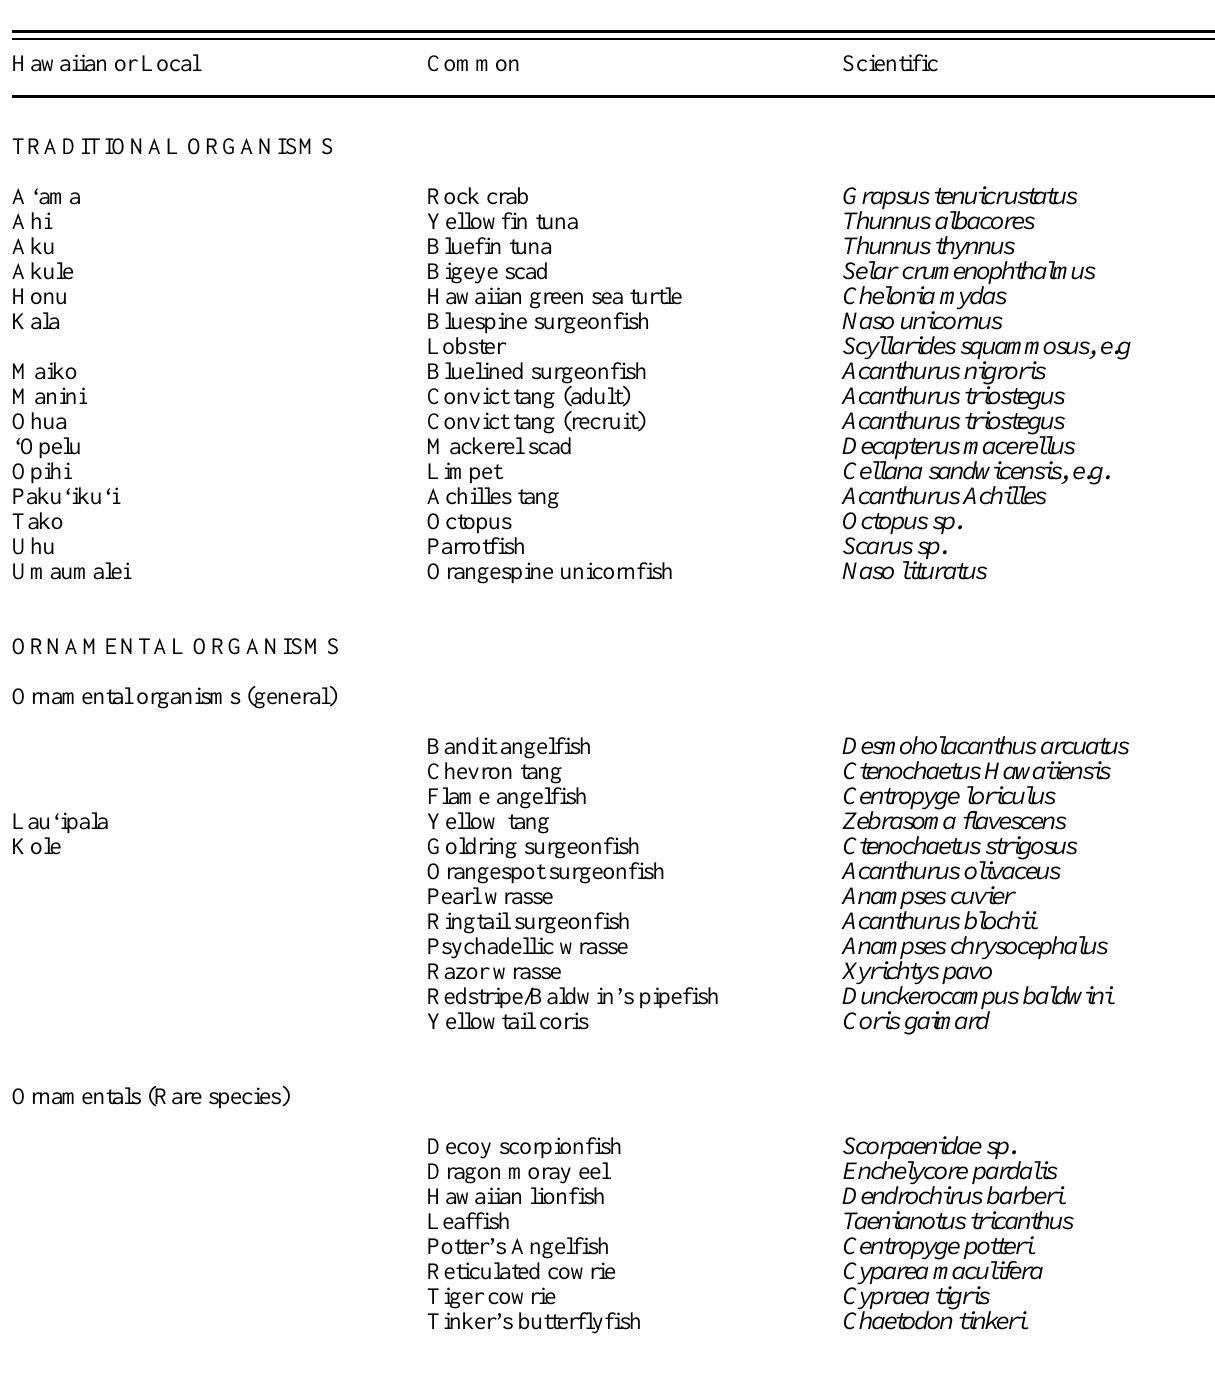
Table 5. Examples of species in social-ecological guilds. Organisms are alphabetized by the name most commonly used (Hawaiian, common, or scientific). If the Hawaiian name was not used, it is not included in this